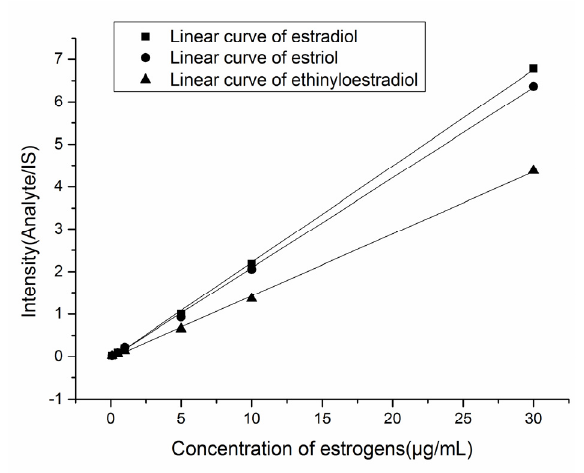
Figure 4. The linear curves of estradiol (Y = 0.2267x − 0.0482, R 2 = 0.9995), estriol (Y = 0.2125x − 0.037, R 2 = 0.9994), and ethinyloestradiol (Y = 0.1463x − 0.0344, R 2 = 0.9991) after FluMP derivatization.